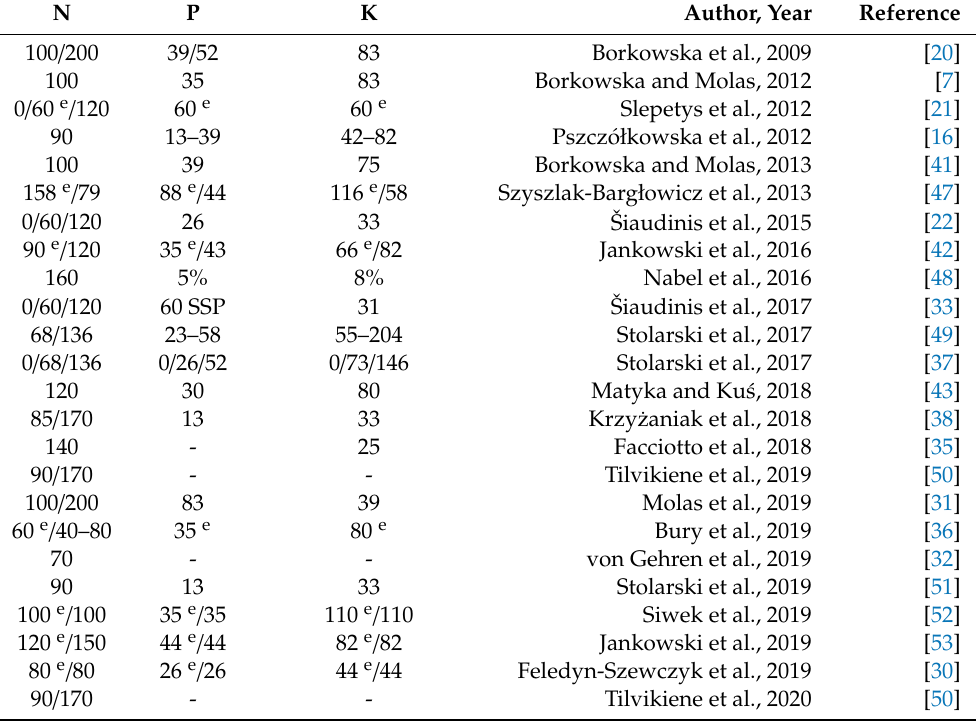
Table 2. Reported fertiliser application rates for S. hermaphrodita (kg ha − 1 ). Values are for N, P, and K unless indicated otherwise.